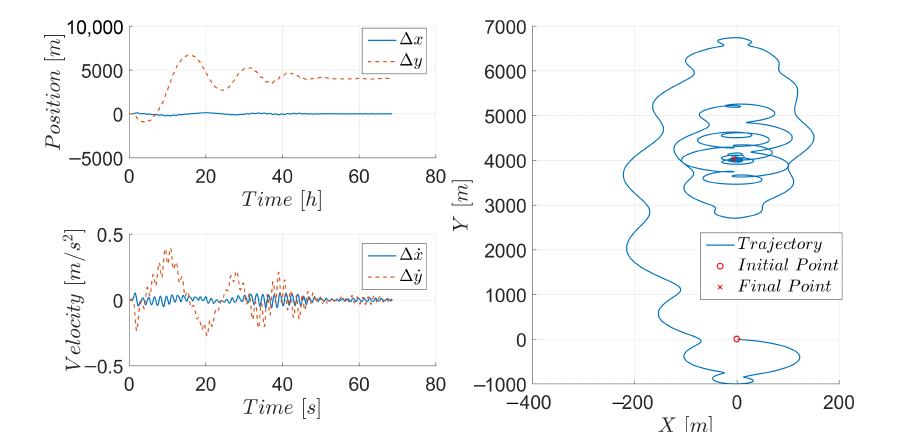
Figure 4. Relative states for the roto-translational maneuver.